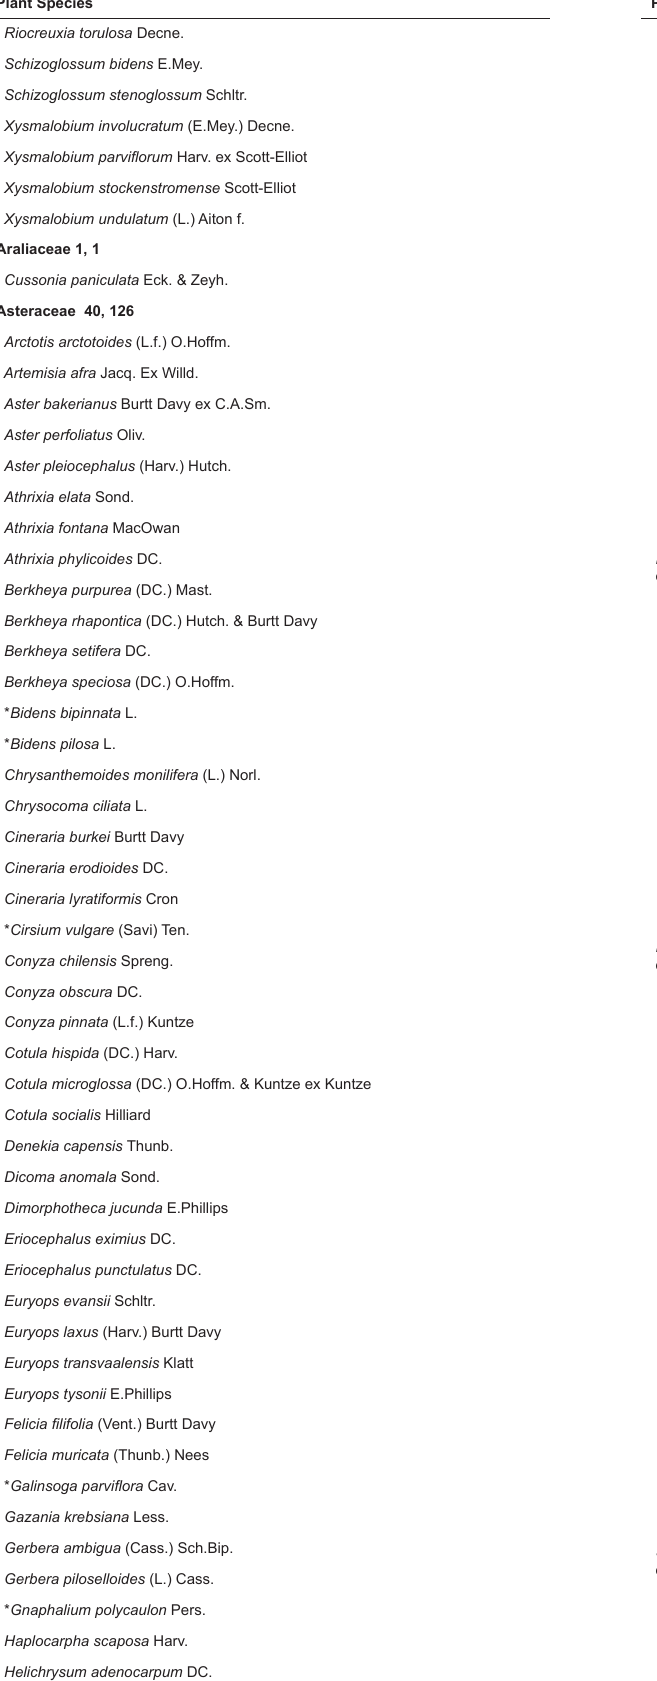
Plant Species Plant